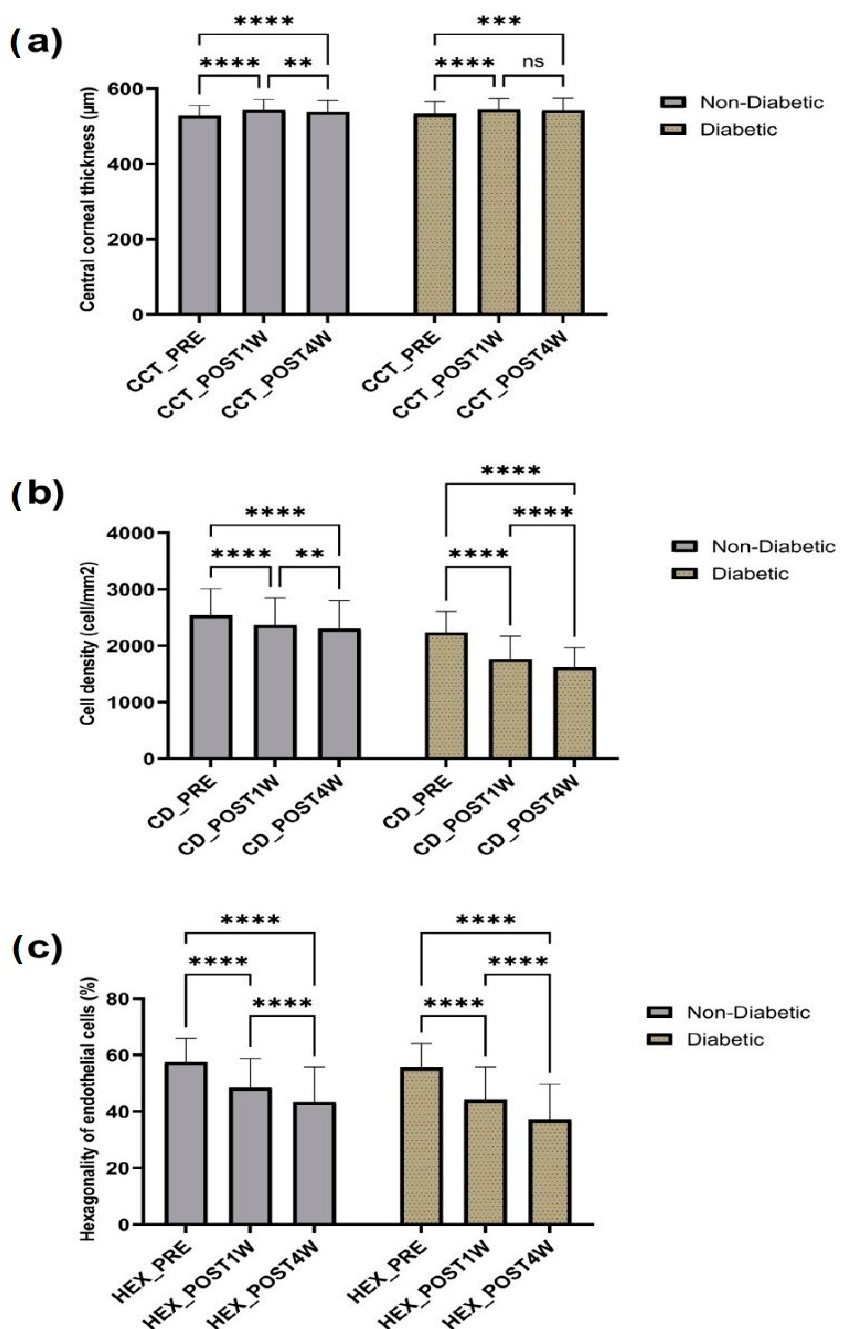
Figure 6. Effect of surgery on central corneal thickness ( a ), cell density ( b ), and hexagonality of endothelial cells ( c ). Data are presented as the mean ± SD and compared using repeated ANOVA.